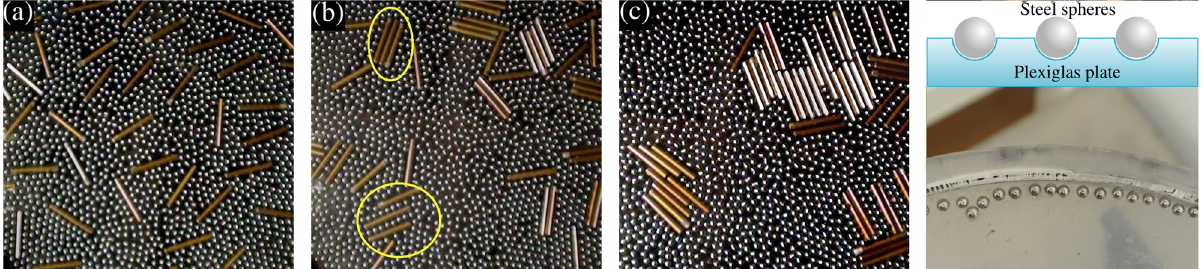
Fig 1. Initial configuration of a mixture of rods and spheres (a) and its evolution after fifteen (b) and thirty minutes (c). In (d) we show a sketch of the edge of the plate with embedded spheres and a close-up to it. Highlighted in (b) are direct depletion aggregates (DDA) and indirect depletion aggregates (IDA). Rods are 23.1 mm long, and they are used as scale